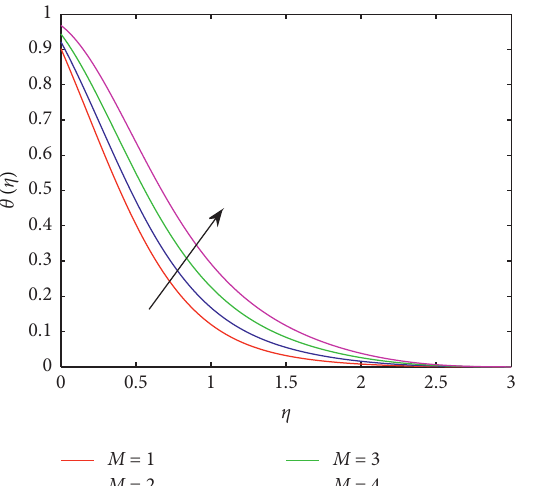
Figure 2: Variation due to M in θ ( η ) . Figure 4: Variation due to Pr in θ ( η ) .